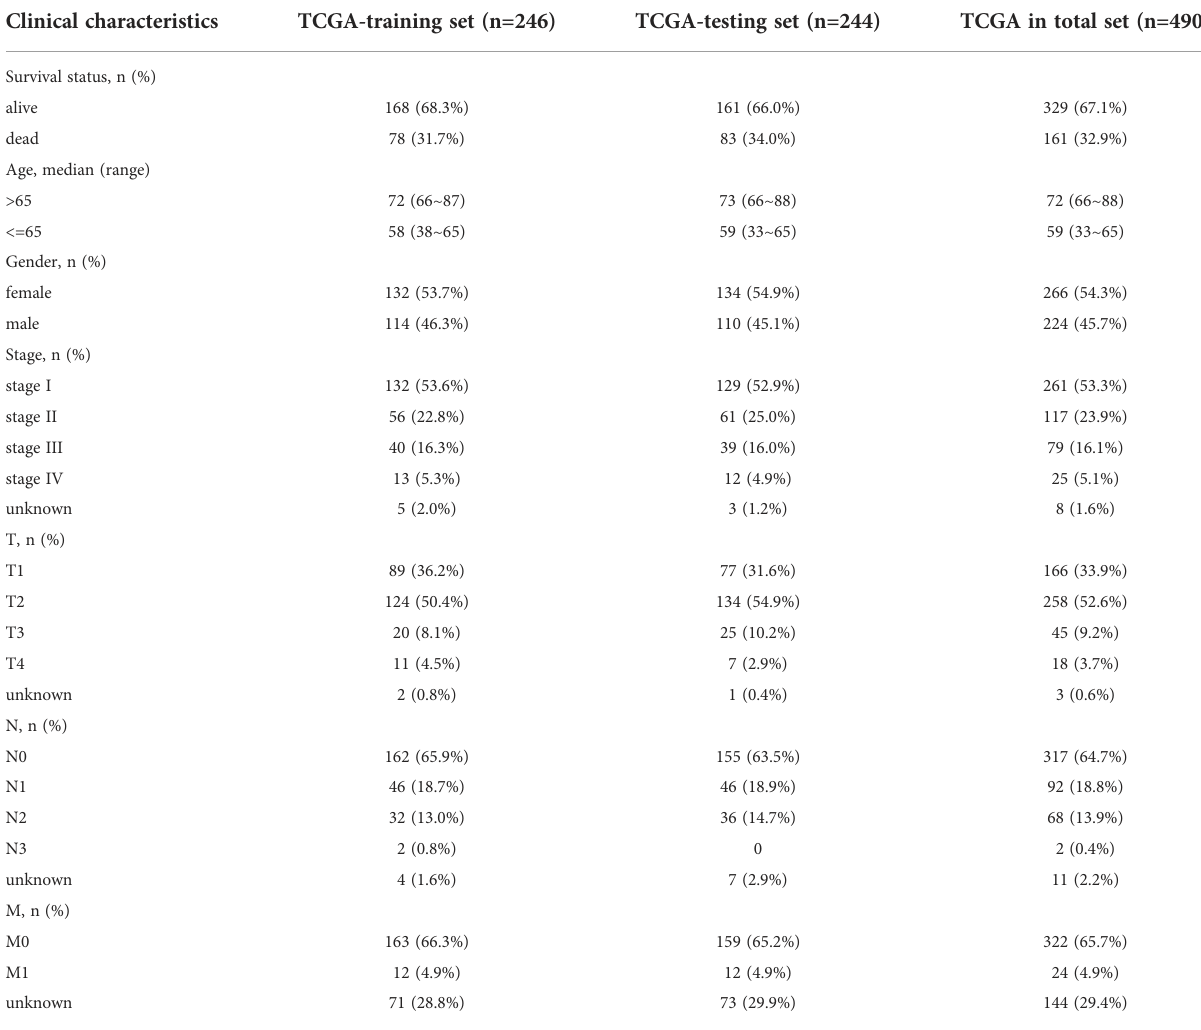
TABLE 1 The baseline characteristics of LUAD patients in the three sets of TCGA cohort. Clinical